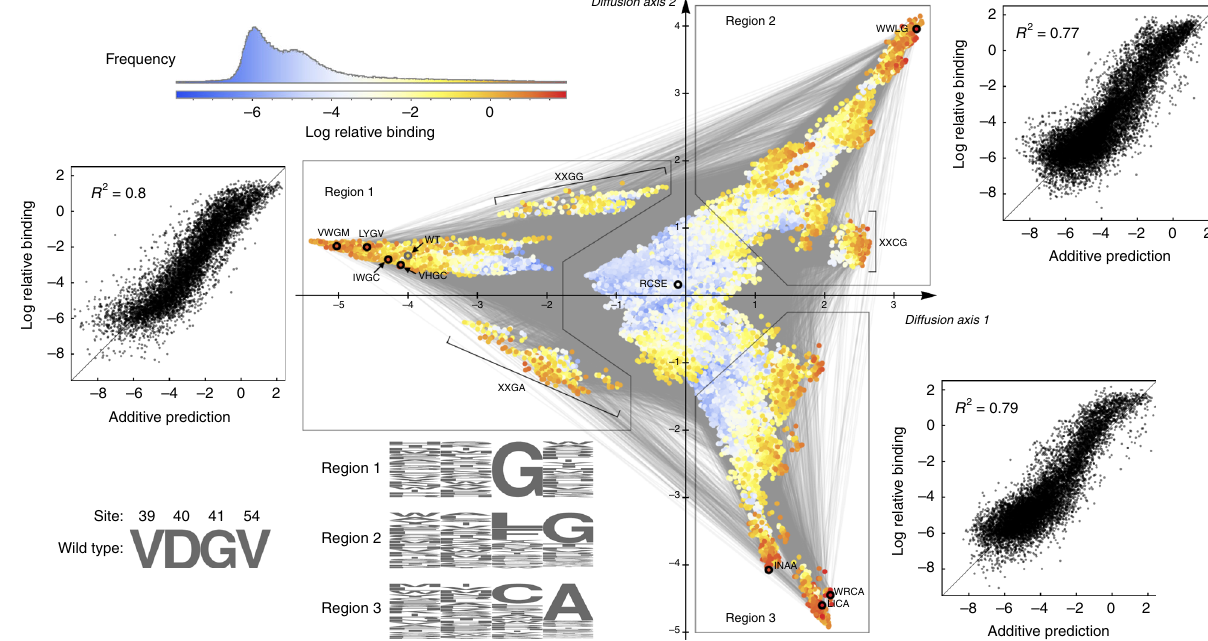
Fig. 5 Visualization of the GB1 landscape reconstructed using minimum epistasis interpolation and the local nonepistatic smoother. Genotypes are plotted using the dimensionality reduction technique from ref. 47 (see “ Methods ” ). Points are genotypes, colored according to their smoothed binding phenotype, and two genotypes are connected by an edge if they differ by a single amino acid substitution. Local fi tness peaks are highlighted by black circles. The x - and y -axis are, respectively, the fi rst and second diffusion coordinate and have units of square-root expected neutral substitutions per site. Three high- fi tness regions are characterized by their distinct sequence composition (sequence logos, see Supplementary Fig. 5b for numerical values). The scatter plots show the fi t of an additive model to the unsmoothed binding values within each of the three high-binding regions. These scatter plots indicate that, despite the complex pattern of epistasis in the landscape as a whole, the sequence – function relationship is approximately additive within each individual high-binding